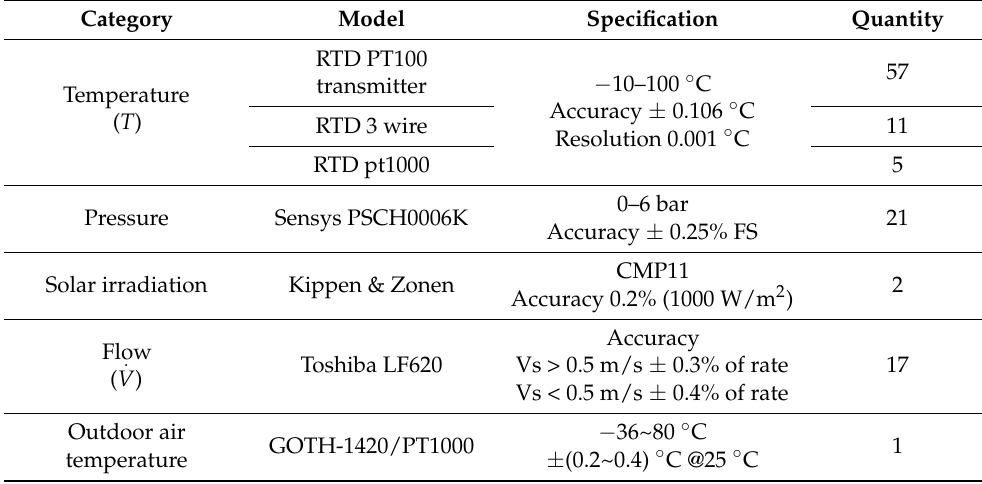
Table 2. Specification of the measurement sensors.